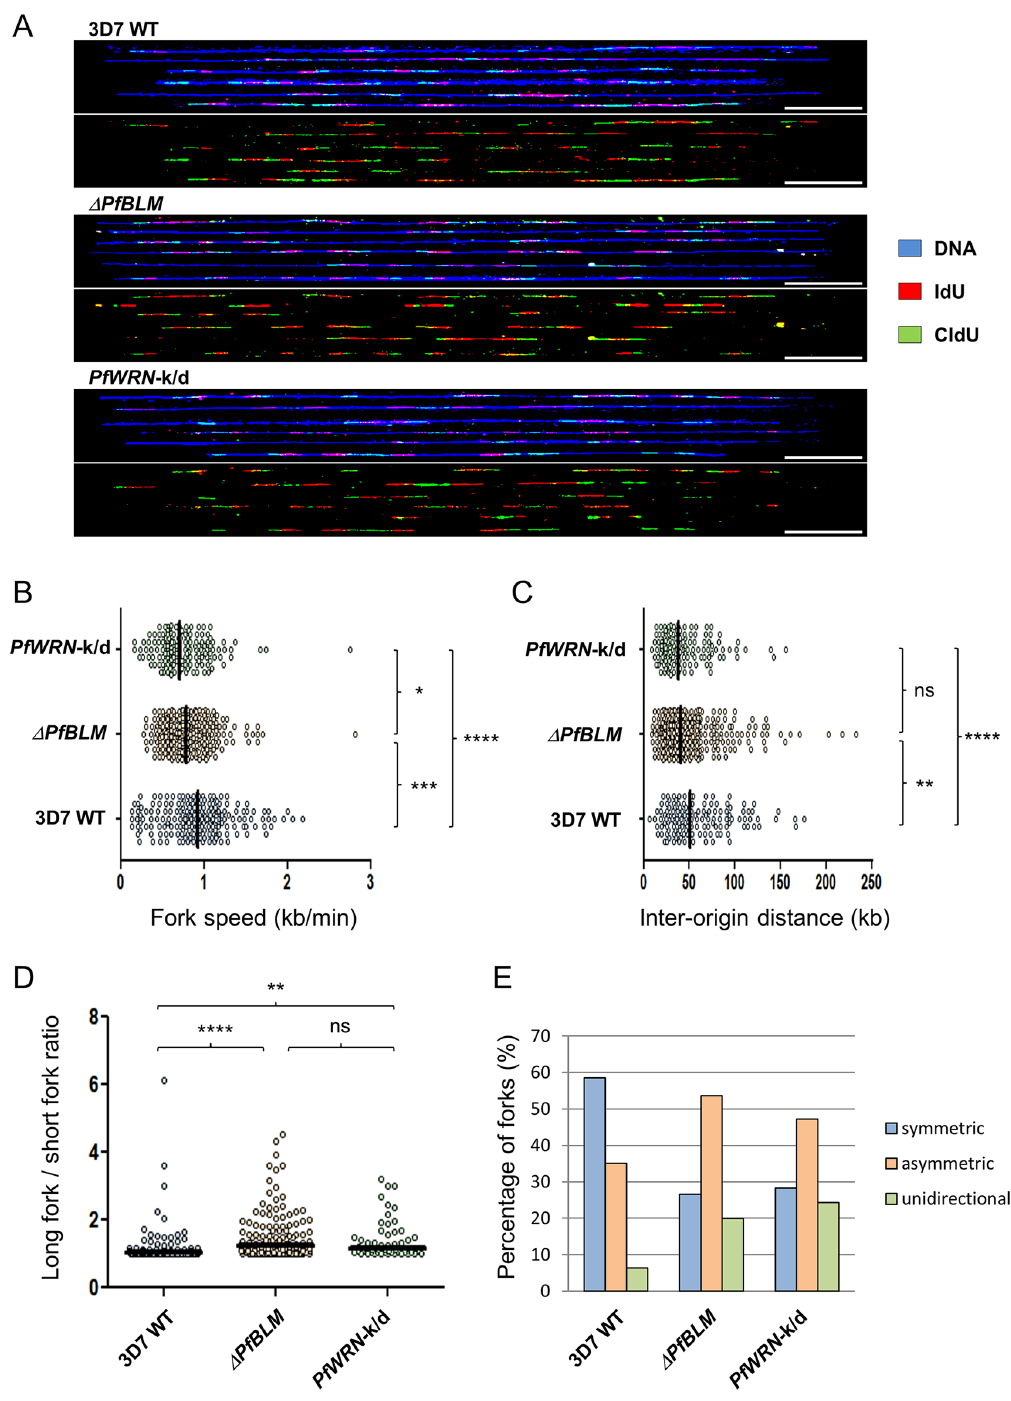
Fig 4. DNA replication parameters in RecQ helicase mutants. (A) Representative DNA fibres from synchronous blood-stage parasites. Upper panel: DNA fibres are in blue, IdU in red and CldU in green; lower panel: the IdU and CldU tracks extracted from the upper panel. 50 kb scale bars are indicated. (B, C and D) Comparative analysis of replication fork speed (B) inter- origin distances (C) and asymmetric forks (long fork to short fork ratios) (D) from synchronous blood-stage parasites. Black bars on dot plots indicate median values. The two-tailed Mann-Whitney test was used to calculate the corresponding P values (ns, not statistically significant P value; (cid:3) P < 0.05; (cid:3)(cid:3) P < 0.01; (cid:3)(cid:3)(cid:3) P < 0.001; (cid:3)(cid:3)(cid:3)(cid:3) P < 0.0001). (E) Percentage of symmetric, asymmetric and unidirectional replication forks counted in the wildtype and RecQ helicase mutants. The groups were significantly different by Chi-square test (P < 0.00001).